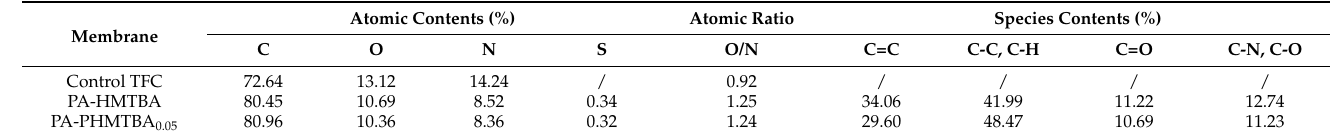
Table 1. XPS surface elemental compositions and high-resolution C1s spectra of the prepar-led membranes. Membrane